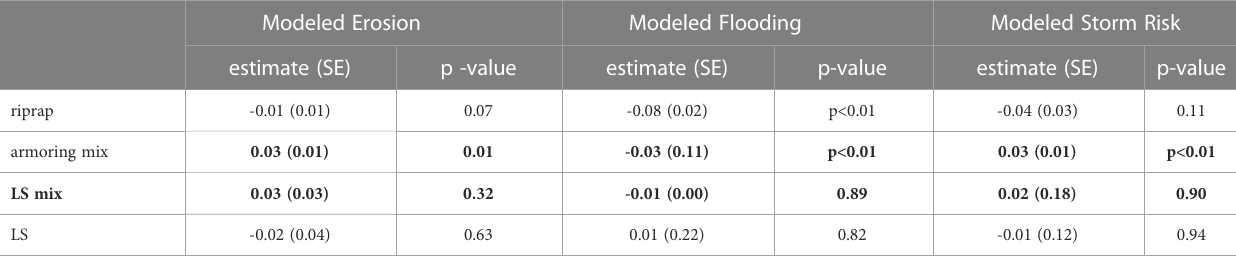
TABLE 8 Marginal effect estimates of modeled